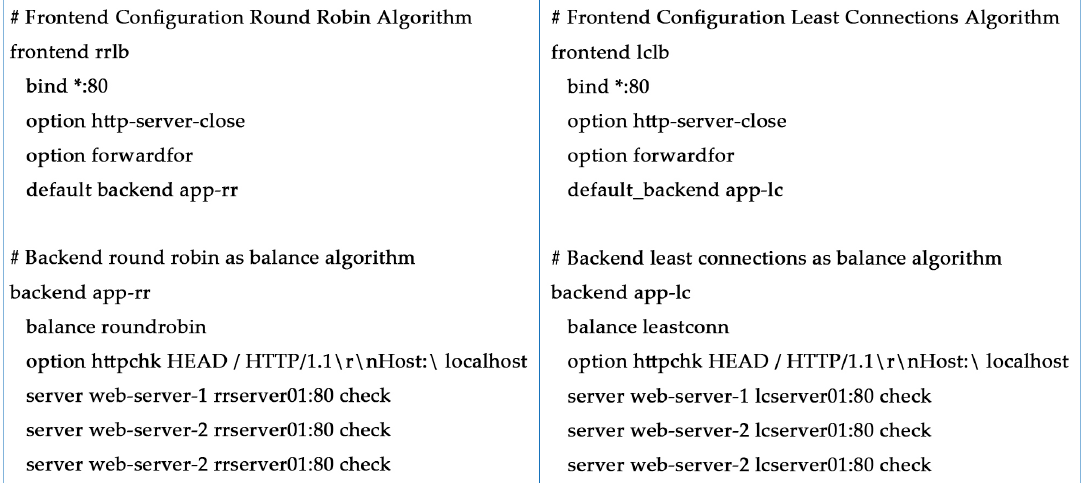
Figure 10. The configuration code of the RR and LC algorithms.